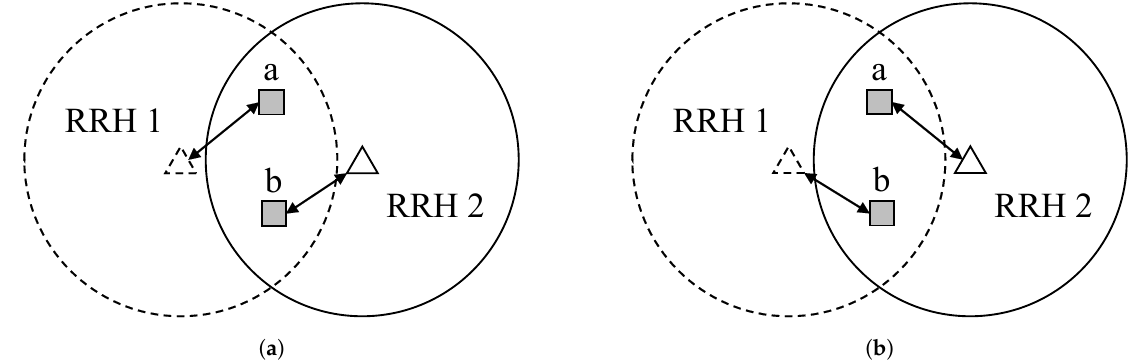
Figure 2. Different but equally optimal load-balancing decisions from the perspective of P. (2). ( a ) Association at time t ; ( b ) Association at time t +